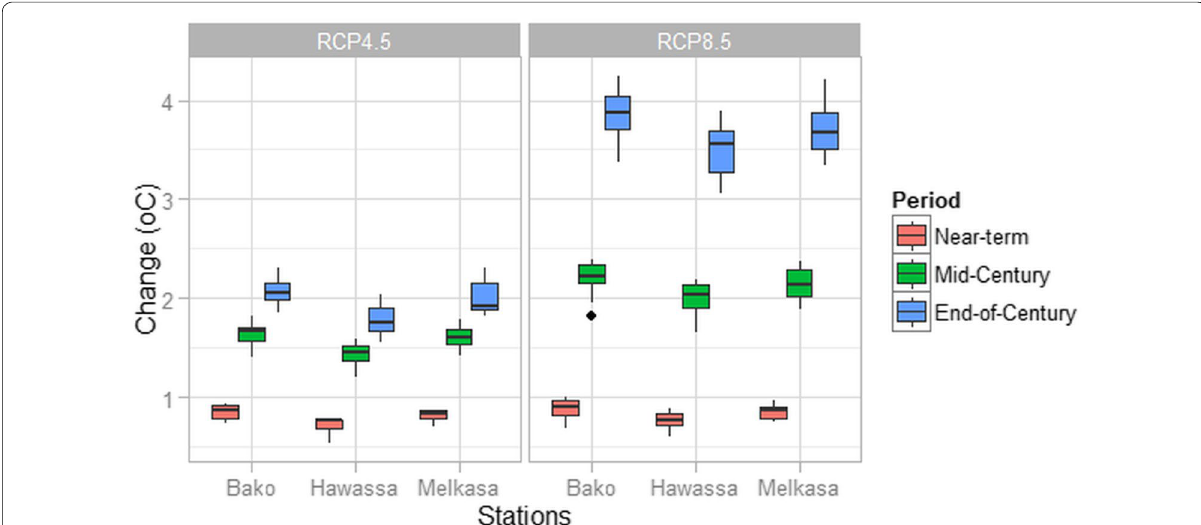
Fig. 2 Projected changes in monthly maximum temperatures for RCP4.5 (left) and RCP8.5 (right) for near term, mid-century and end of century future periods